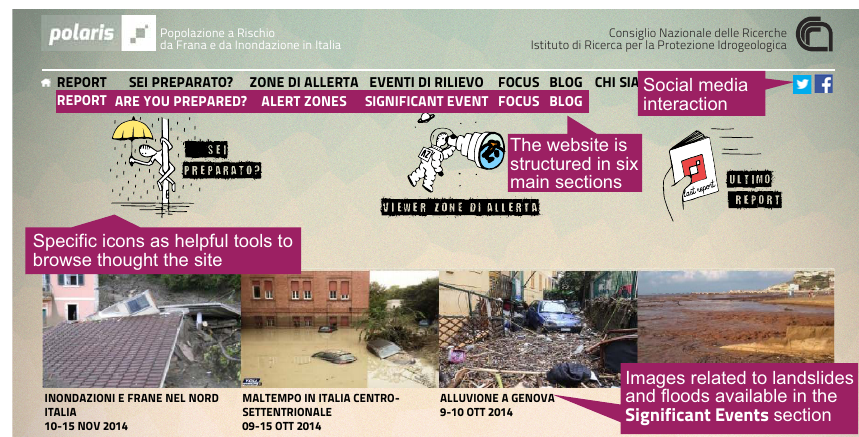
Figure 2. The POLARIS Home Page (http://polaris.irpi.cnr.it). Violet boxes show English translations of the original Italian text.